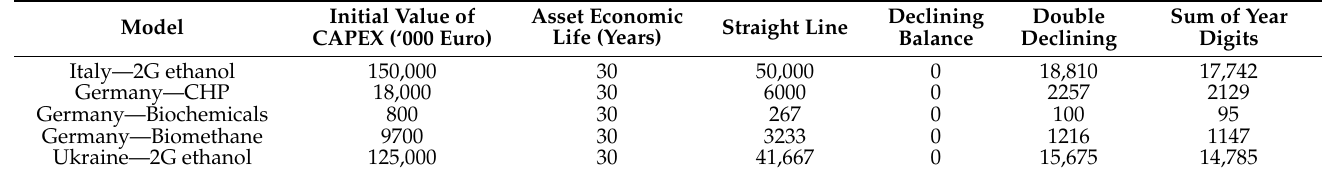
Table A3. NPV parameters for capital investments.